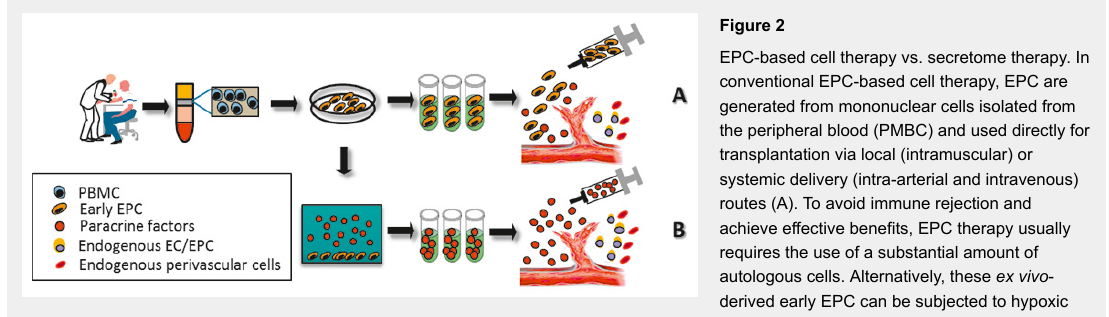
conditions for the secretion of an angiogenic protein. This culture supernatant-obtained secretome can be prepared and injected into the patients (B). The “cell-free” strategy may offer an ideal solution with higher efficacy, easy reproducibility, ready availability and no risk of immune